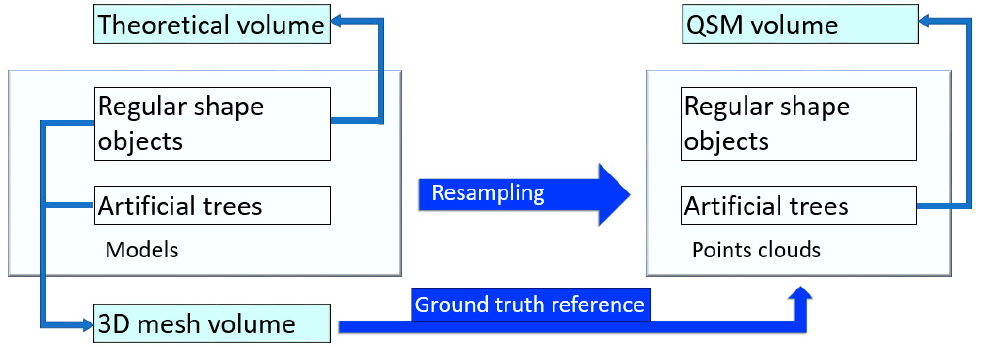
Figure 3. Workflow for preparing artificial ground truths.